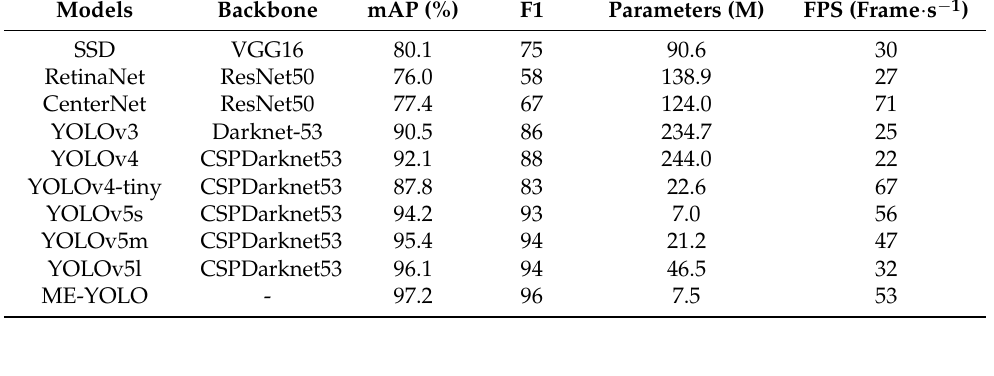
Table 4. Comparison of mainstream object detection models. Models